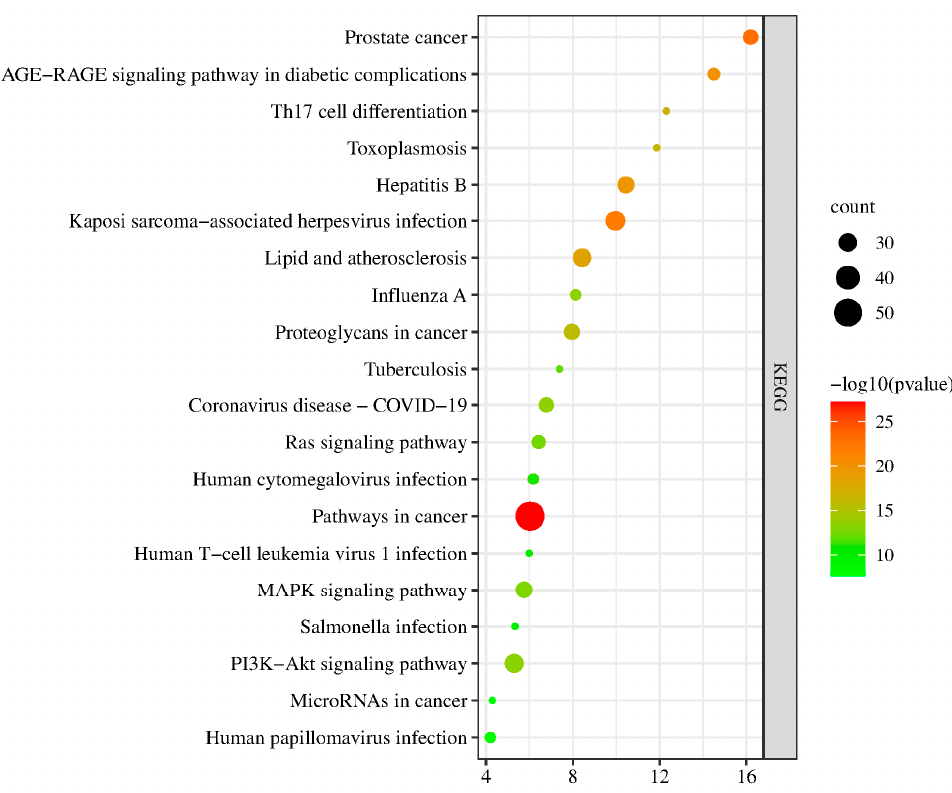
Figure 6. KEGG pathway enrichment of 141 intersection targets. (The top 20 pathways were identified. Color represented p value and size of the spot represented count of genes).